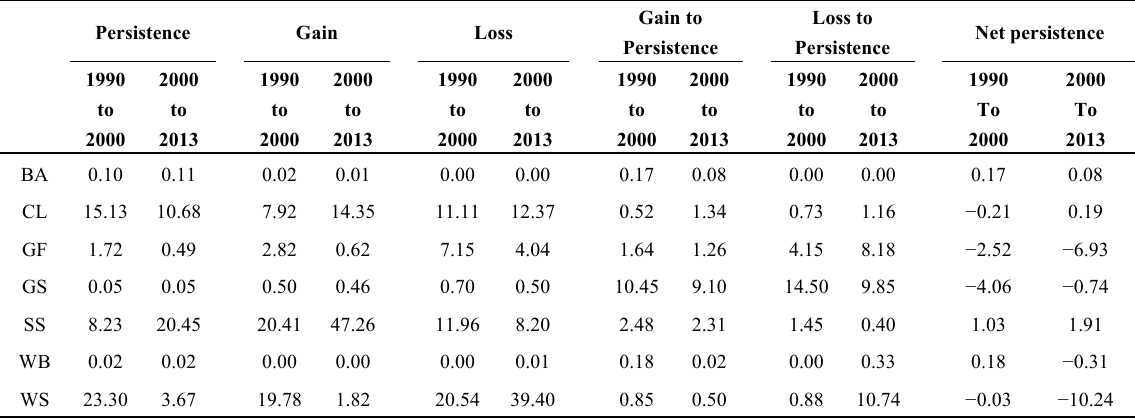
Table 7. Gain-to-persistence ( G ( N ) ratios of the land cover classes in Cassou district between 1990 and p